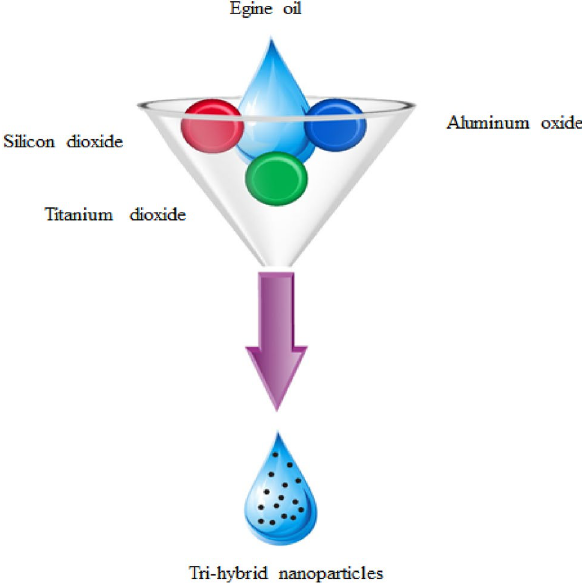
Figure 1. Development of tri-hybrid